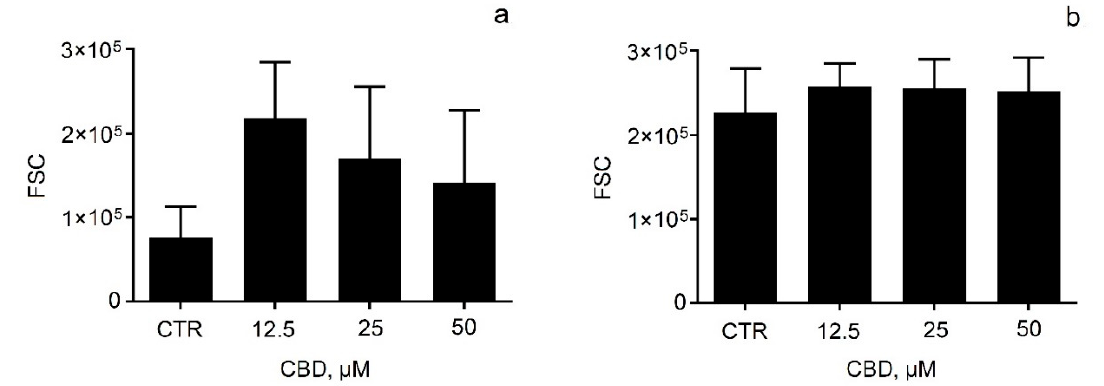
Figure 6. Distribution by cell cycle phase of SH-SY5Y cells ( a ) and Neuro-2a cells ( b ) after 24 h of treatment with different concentrations of pure CBD. Gap 1/quiescent phase (G0/1), synthesis phase (S), gap 2/mitosis phase (G2/M), and apoptotic cells (sub-G0). Values are presented as the percentage of the cell population in studied samples.